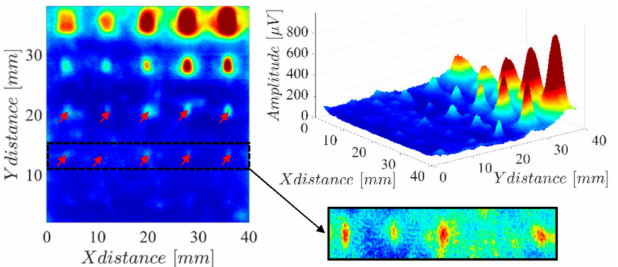
Figure 3. Amplitude imaging result measuring coil 3 (68 µ H) on a two-dimensional scan over the several holes of the LPBF-produced part.